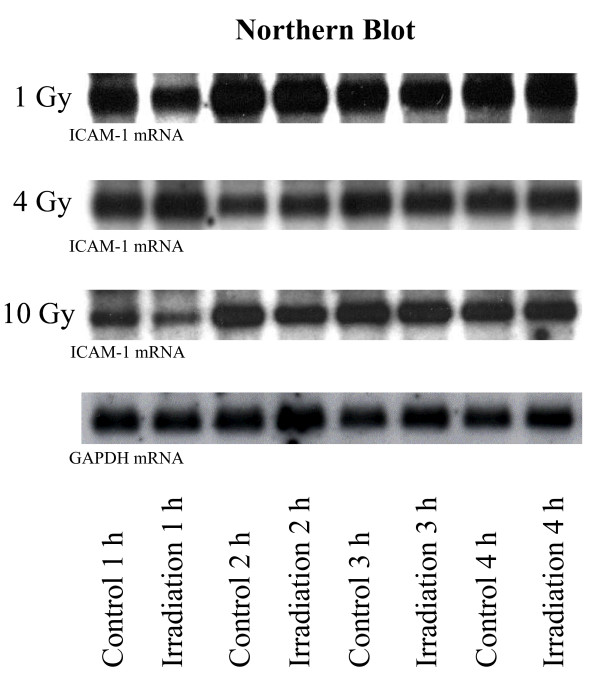
Northern blots of ICAM-1 expression 1 h, 2 h, 3 h, and 4 h after low dose irradiation of human MC with doses of 1 Gy, 4 Gy, and 10 Gy. Expression of ICAM-1 in quiescent MC was not affected by low dose irradiation, GAPDH was used as control.